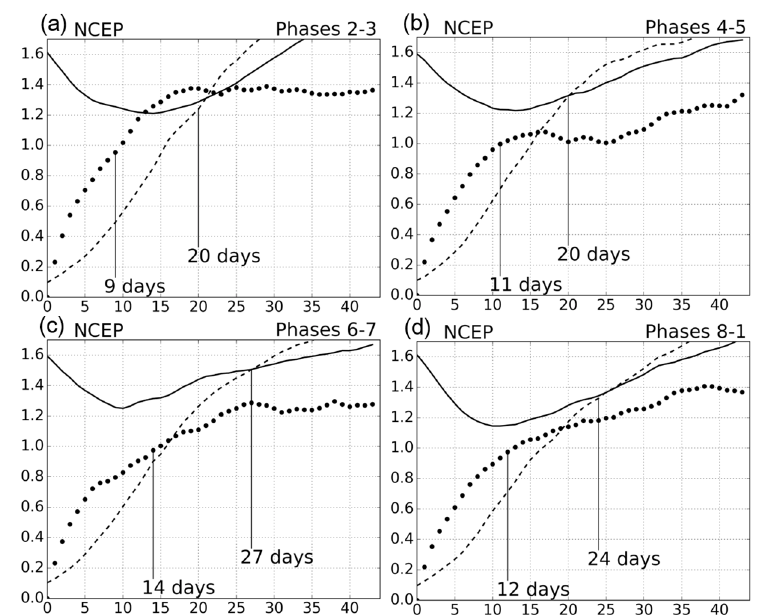
Figure 7. MJO amplitude (solid line), ensemble spread multiplied by √2 (dashed line), and a maximum possible value of the initial-value error for the NCEP model (dotted line), averaged over forecasts initially starting from ( a ) Phases 2–3, ( b ) Phases 4–5, ( c ) Phases 6–7 and ( d ) Phases 8–1. Table 4. The list of prediction limits for the ECMWF model (day) for forecasts from each MJO phase with the proposed and conventional methods.